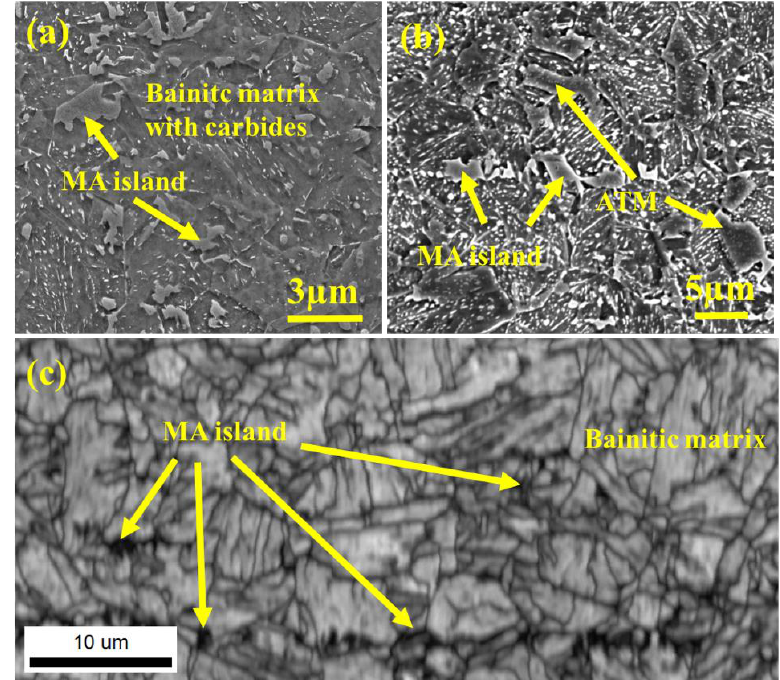
Figure 2. Scanning electron micrographs of the bainitic steel under consideration: ( a ) SEM micrograph of the microstructure etched by Klemm; ( b ) SEM micrograph of the microstructure etched by Nital; ( c ) image quality map and the fraction of retained austenite is negligible ( < 1%). The rolling direction is along the horizontal axis and the normal direction is along the vertical axis. ATM, auto-tempered martensite; SEM, scanning electron microscope.